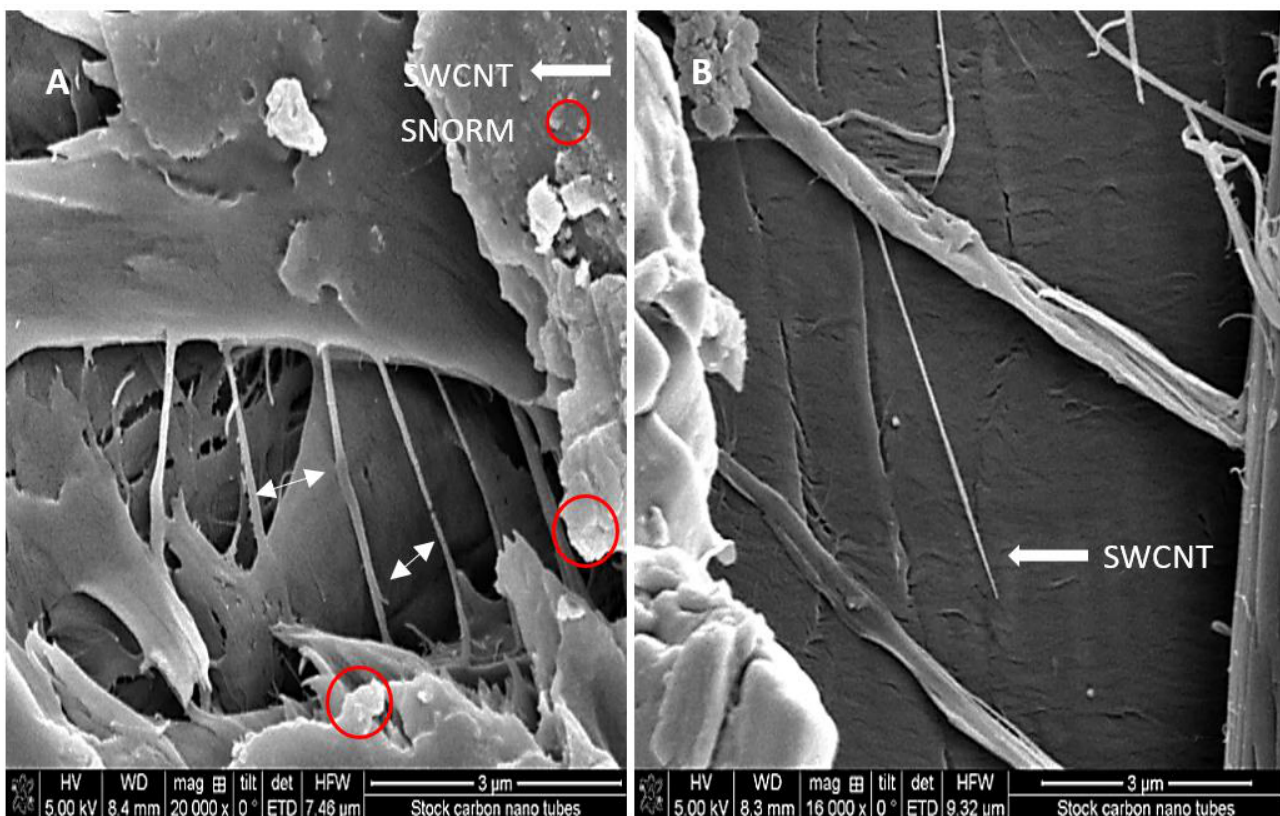
Figure 1. Scanning electron microscope images of SWCNT. ( A ) Crystallized SWNT-SRNOM films ( B ) SEM image of an individual SWCNT partly encased in SRNOM.